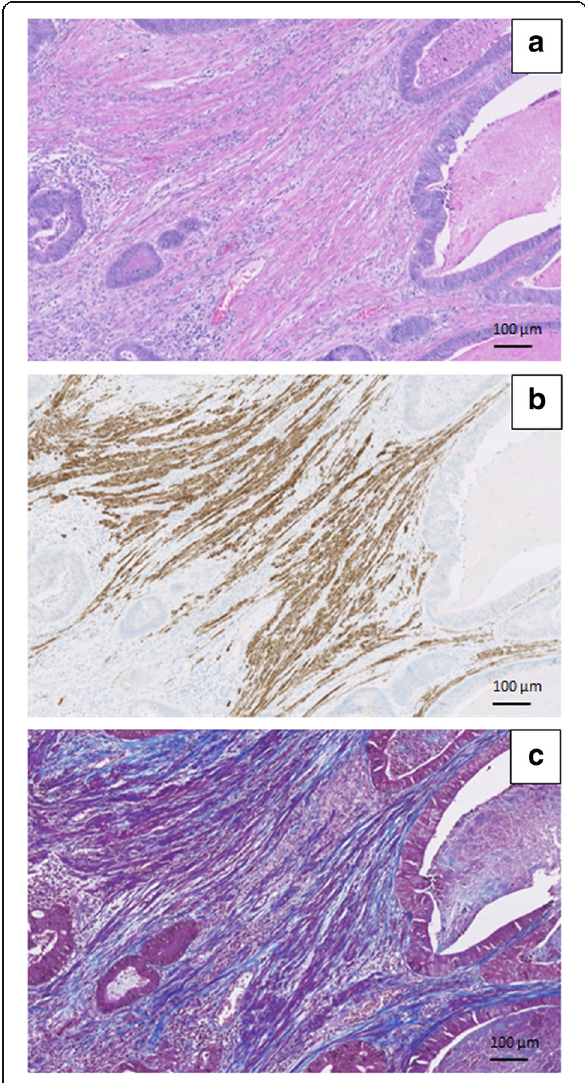
Fig. 3 How to distinguish fibrous tumour stroma from smooth muscle tissue. a In the H&E stained section it is challenging to distinguish between fibrous stroma and smooth muscle tissue. b Immunohistochemical stain for desmin highlights the smooth muscle tissue. c Masson trichrome highlights the collagen fibres in the fibrous stroma (blue) and the smooth muscle tissue